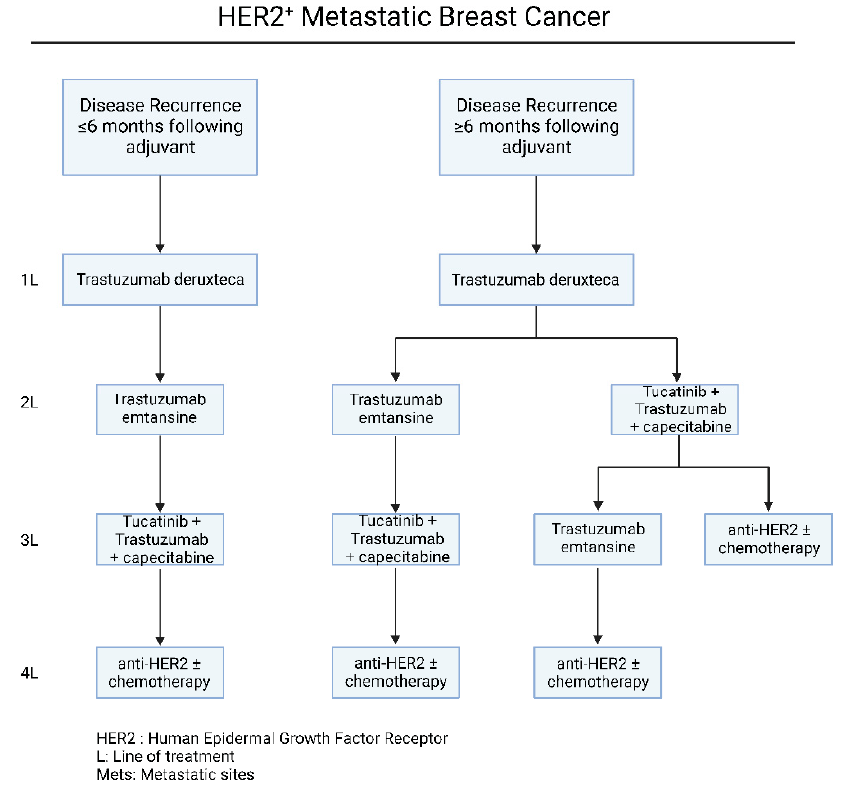
Figure 4. Current therapeutic algorithm for the management of HER-2 + mBC. Proposed therapeutic algorithm for patients with HER-2 + metastatic breast cancer [52]. The abbreviations of the terms used in the figure are outlined in the lower part of the algorithm.